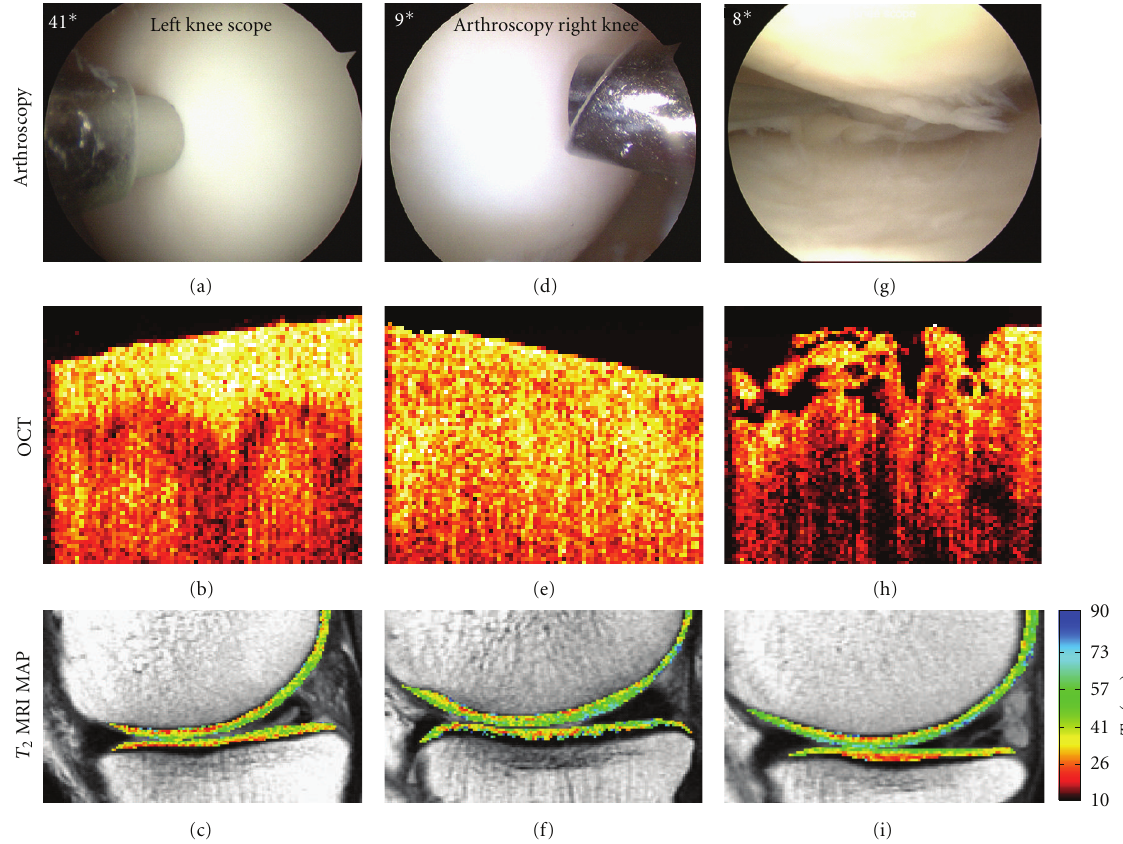
Figure 3: Representative images obtained during arthroscopy, optical coherence tomography (OCT), and magnetic resonance imaging (MRI) T 2 mapping relaxation times. The higher the T 2 relaxation time reflects a greater degree of hydration which may correlate with increased articular cartilage degeneration. ((a)–(c)) arthroscopically firm (a), OCT with birefringence (b), and MRI T 2 mapping (c). ((d)– (f)), arthroscopically firm (d), OCT without birefringence (e), and MRI T 2 map (f). ((g)–(i)), arthroscopic fissuring (g), OCT with surface fissuring and fibrillation (h), and MRI T 2 map